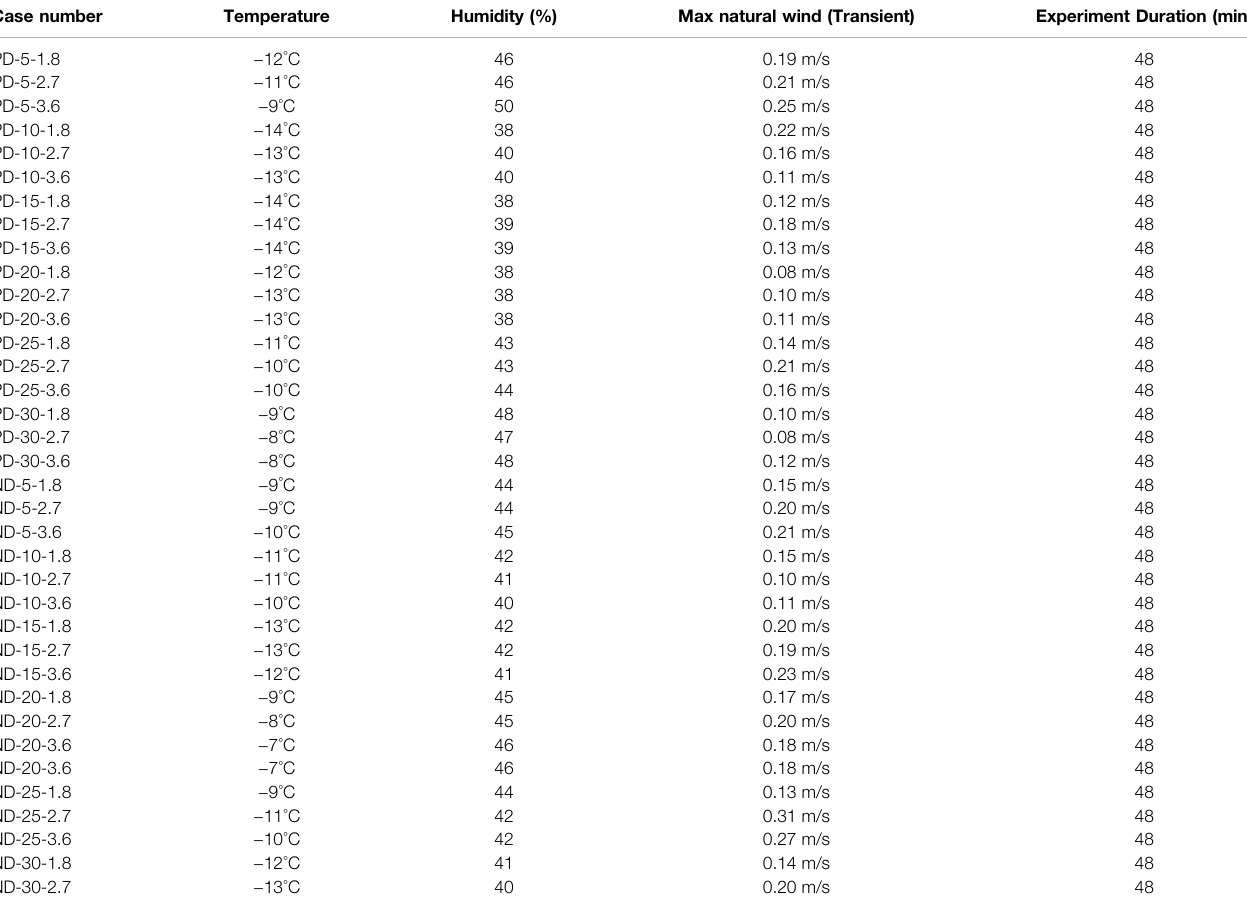
TABLE 5 | Experiment cases and environmental conditions.